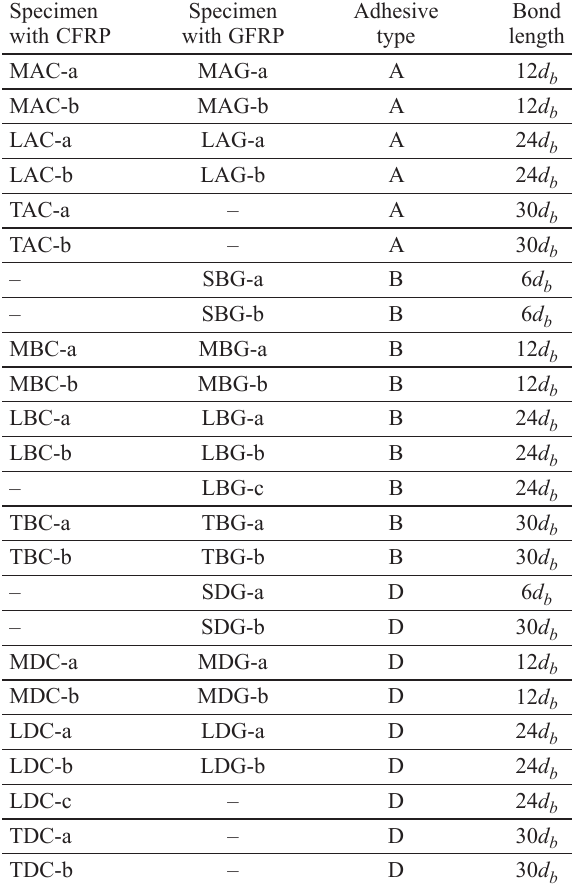
Specimen with GFRP